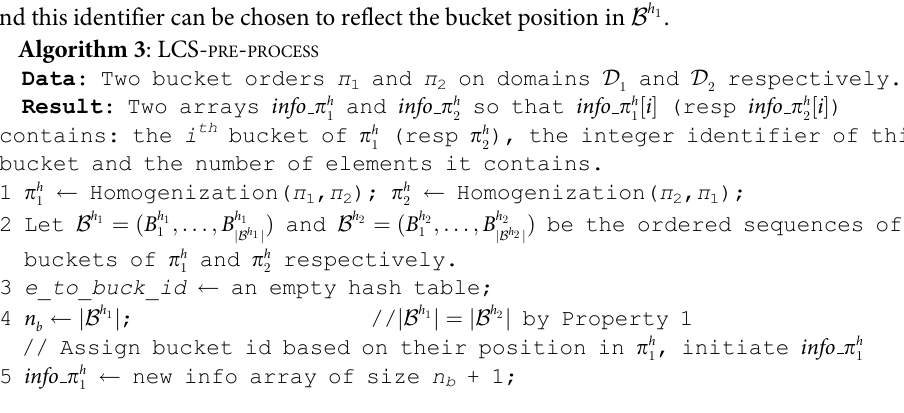
Algorithm 3 : LCS- PRE - PROCESS